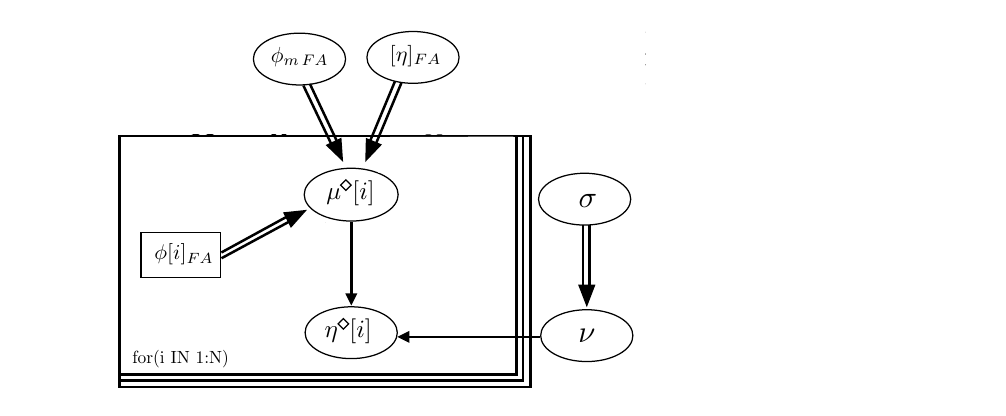
Figure 7. Graph of the Bayesian network of the Krieger–Dougherty equation in self-compacting mortar. Table 5. Statistics of the parameters φ mFA and [ η ] FA for self-compacting mortar.